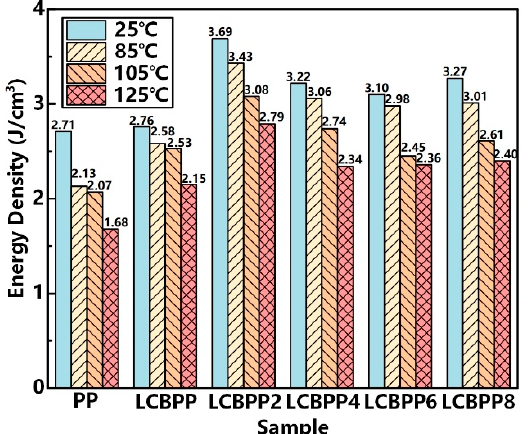
Figure 13. The energy density of testing samples at different temperatures.